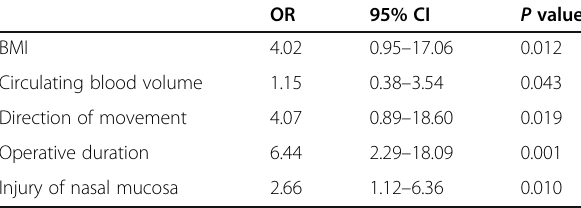
Table 2 Results of the binomial logistic regression analysis